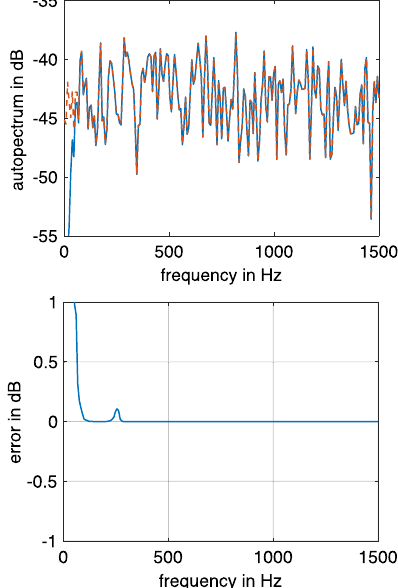
Figure 8. The upper curve shows the comparison of the original source spectrum (dashed line) and reconstructed source spec- trum (solid line). The lower curve shows the difference between original source spectrum and reconstructed source spectrum.